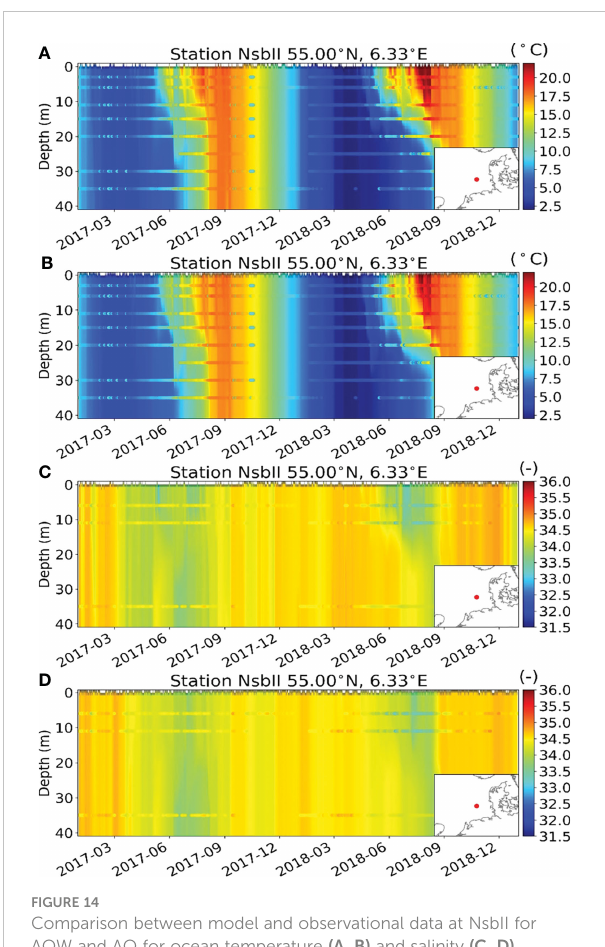
FIGURE 14 Comparison between model and observational data at NsbII for AOW and AO for ocean temperature (A, B) and salinity (C, D) , respectively. The images show the simulated data as Hovmöller diagrams in the shaded background and the collocated observations as colored dots in the foreground. The color coding is the same for both data